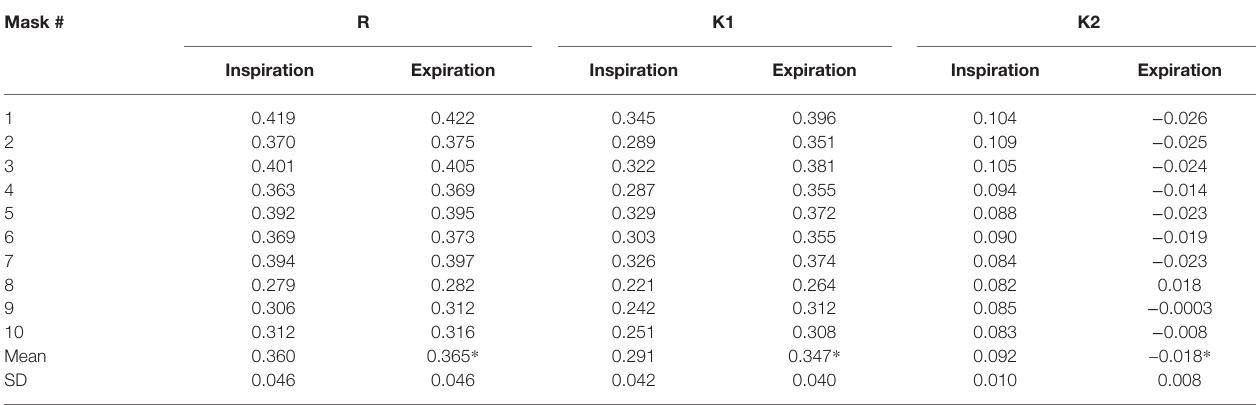
TABLE 3 | The mask resistance (R), the mask resistance extrapolated at zero flow (K1) and flow dependent component of resistance (K2) during inspiration and expiration, expressed as mean calculated from set 1–4. Mask # R K1 K2 Inspiration Expiration Inspiration Expiration